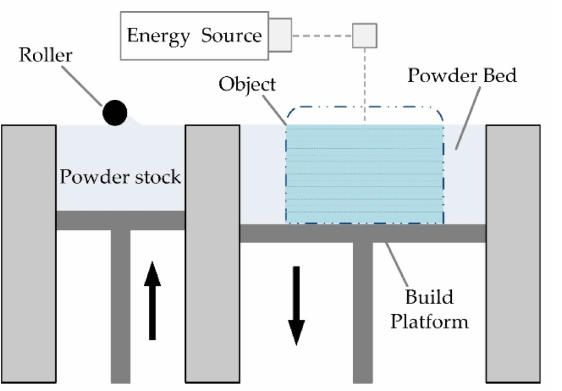
Figure 10. Illustration of the general PBF printing process. (Reprinted from Metals , Volume 9, Long Bai, Cheng Gong, Xiaohong Chen, Yuanxi Sun, Junfang Zhang, Lecai Cai, Shengyan Zhu and Sheng Quan Xie, Additive Manufacturing of Customized Metallic Orthopedic Implants: Materials, Structures, and Surface Modifications, 1004, Copyright (2019), with permission from Metals , MDPI, Basel, Switzerland, under the terms of the Creative Commons Attribution License: http://creativecommons.org/licenses/ by/4.0/, accessed on 15 November